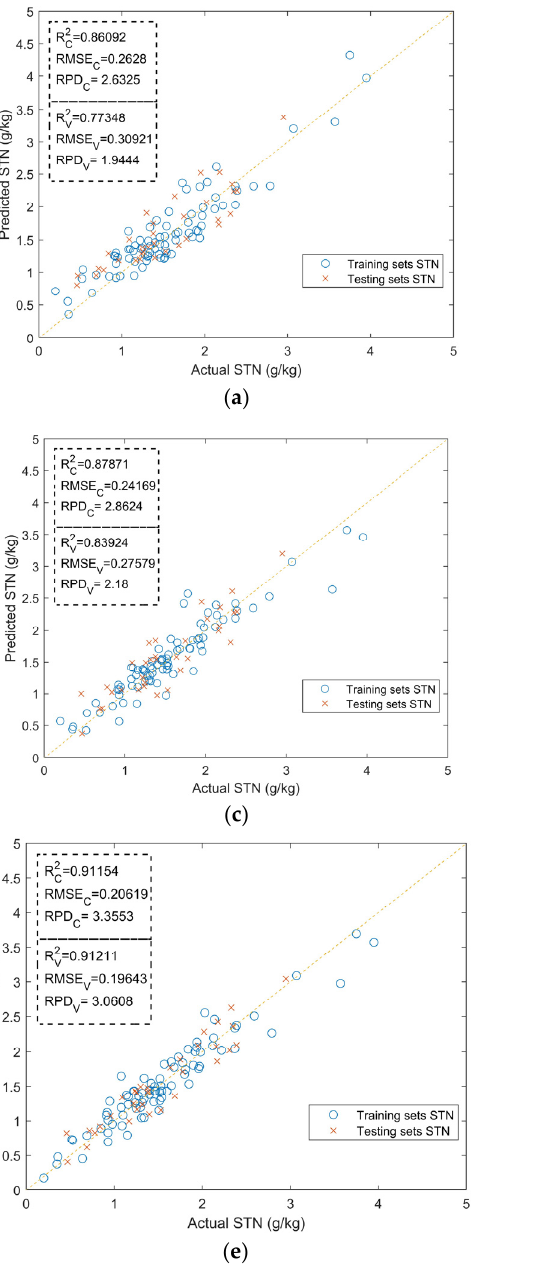
Table 5. Test set data.